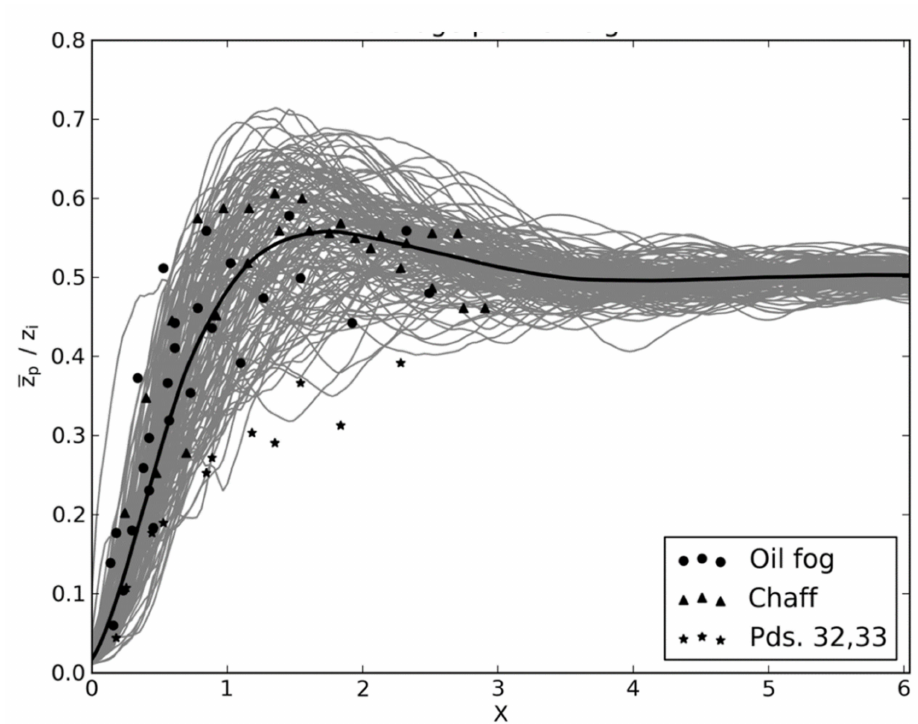
Figure 9. Normalized plume height as a function of the downwind distance. The gray lines depict 100 individual realizations from the JOULES and the black line represents the average of those realizations. The circles and triangles represent observations measured during the CONDORS